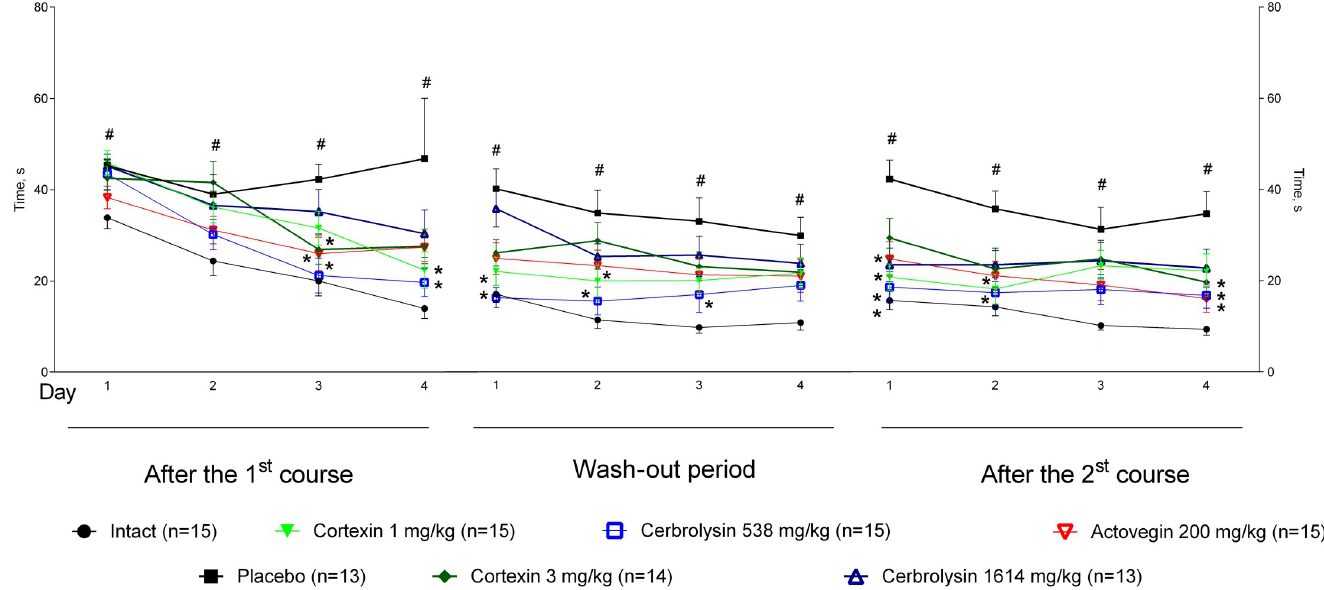
Fig 8. Morris water maze performance in rats with chronic brain ischemia. #–p < 0.05 compared to Intact; � –p < 0.05 compared to placebo (Kruskal-Wallis rank analysis and the Dunn post-hoc test); data shown as the mean ± SEM).